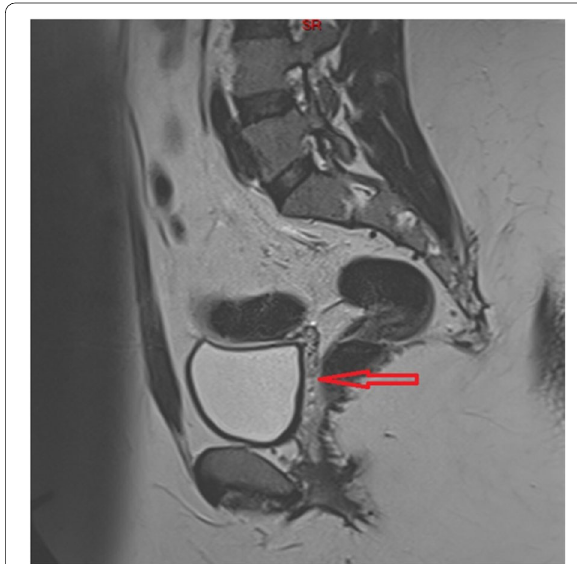
Fig. 5 Sagittal T2WIs pelvic MRI showed hypoplastic upper two-third of the vaginal with cystic remnants (red arrow)